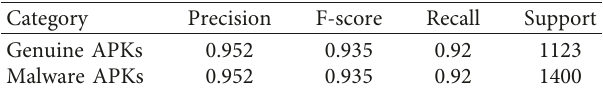
Table 2: Classification statistics for hybrid data set (Play Store/